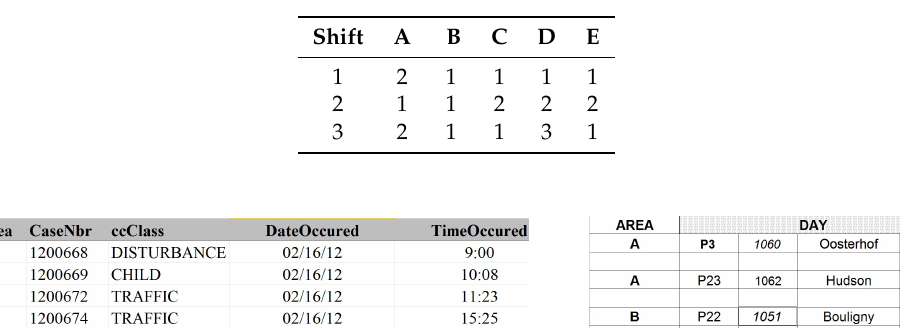
Table 2. Patrol data for 3 shifts.